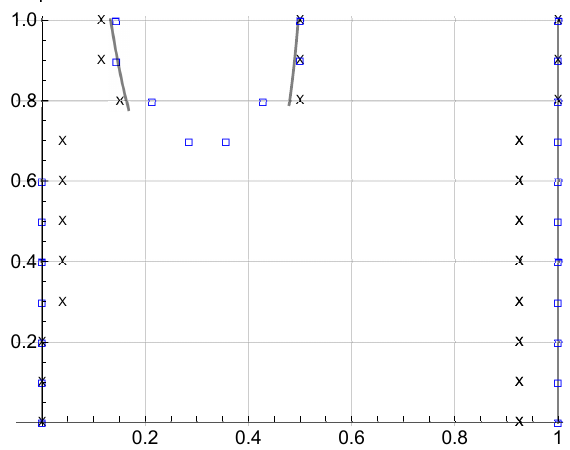
Figure 13. Coupling between the first and third modes. = model solution; (cid:3) = FEM simulations; × = experimental